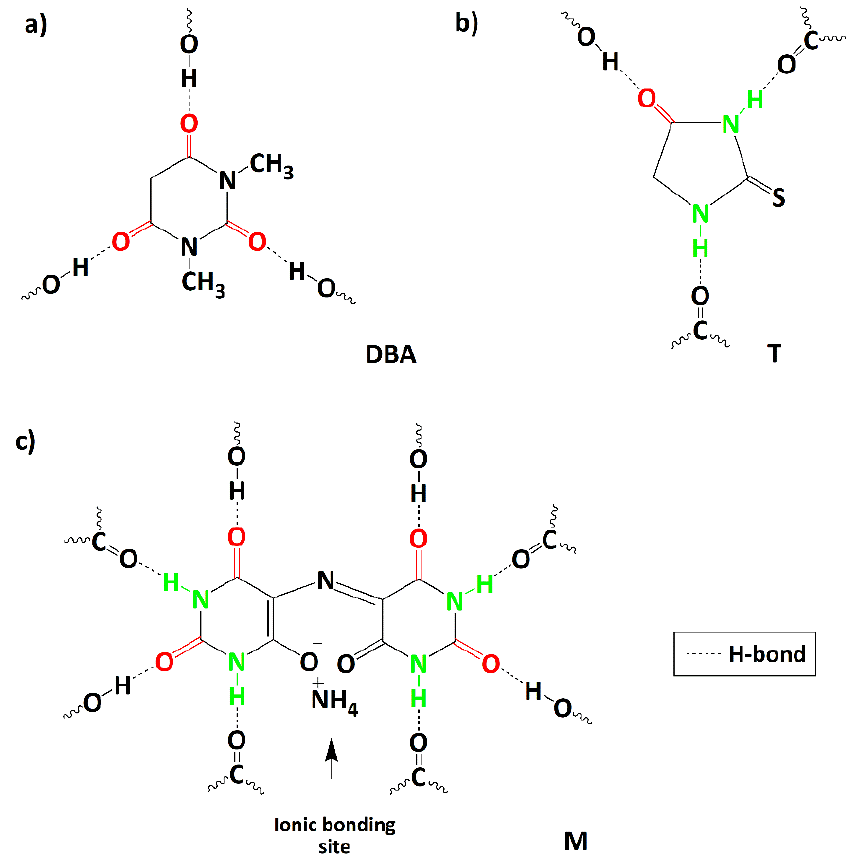
Figure 1. Scheme showing the chemical formulas of the healing molecules and their hydrogen bond ‐ ing donor and acceptor sites: ( a ) 1.3 ‐ Dimethylbarbituric acid (DBA), ( b ) 2 ‐ Thiohydantoin (T), and ( c ) Murexide